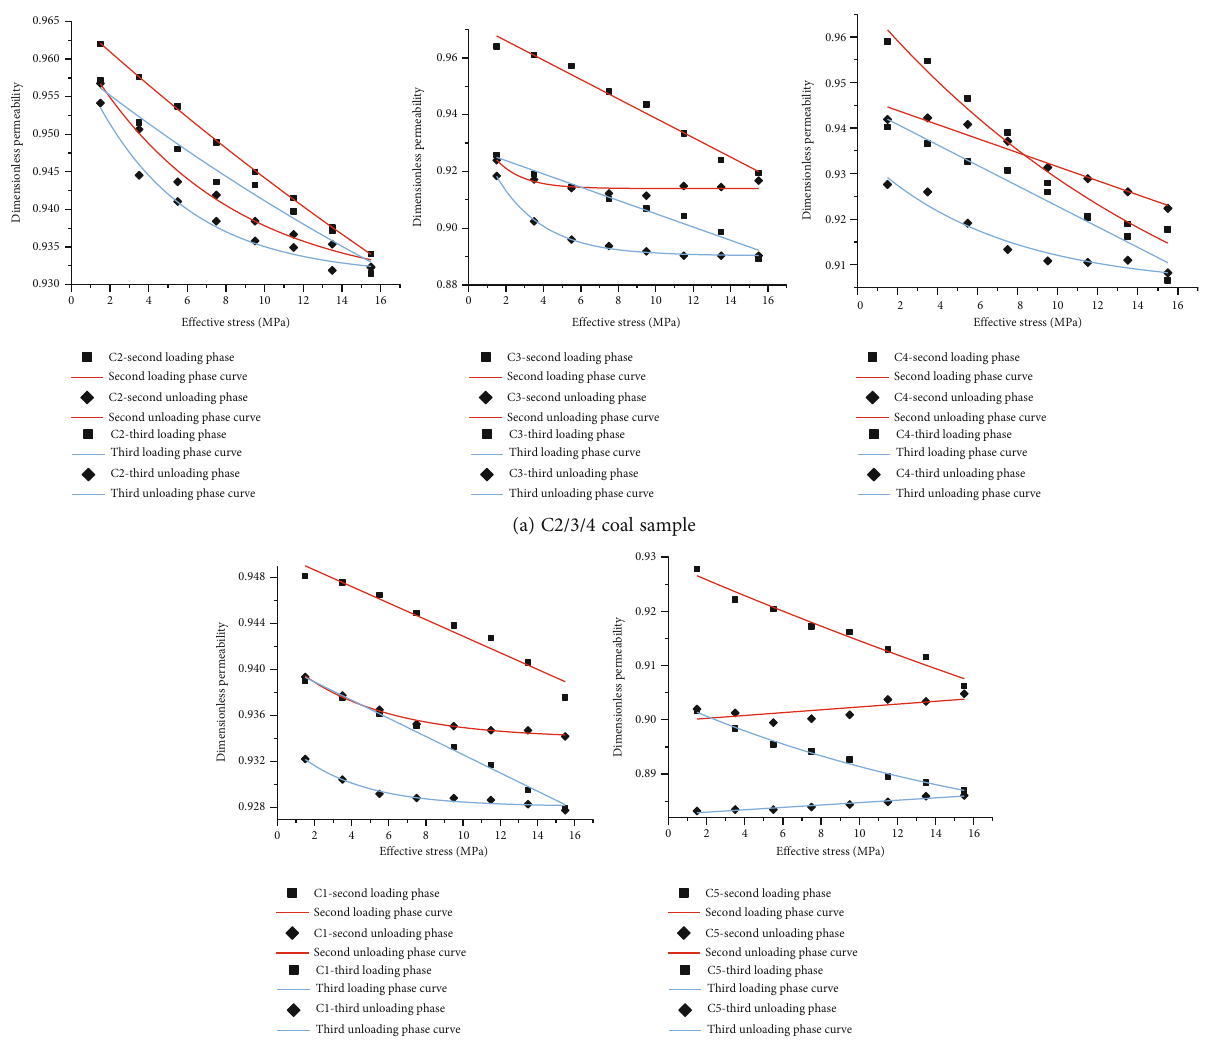
Figure 9: Permeability curves for the second and third loading and unloading cycles.